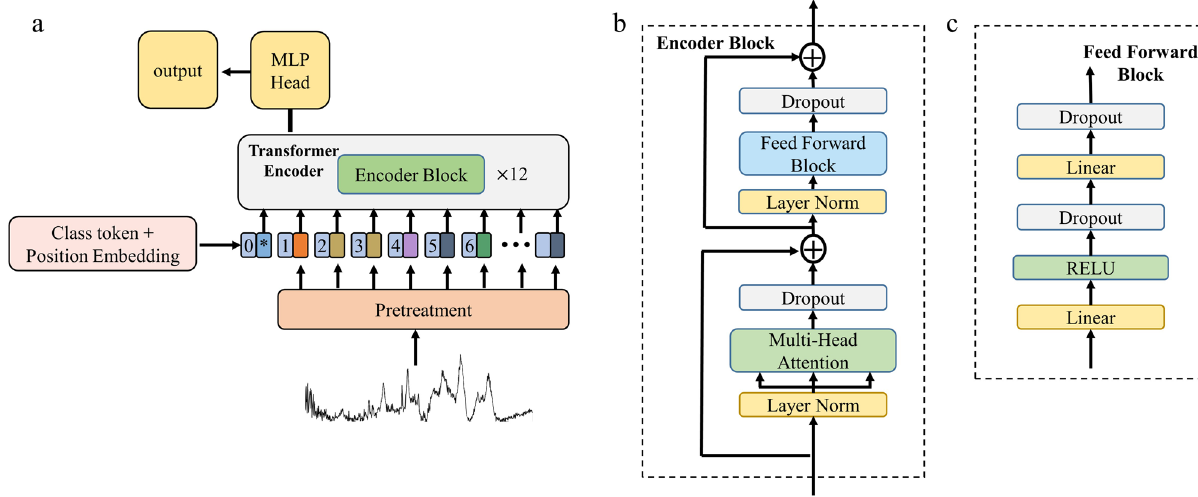
Figure 3. ( a ) Structure diagram of transformer classification model for Raman Spectrum Classification. ( b ) Structure diagram of encoder block. ( c ) Structure diagram of feedforward